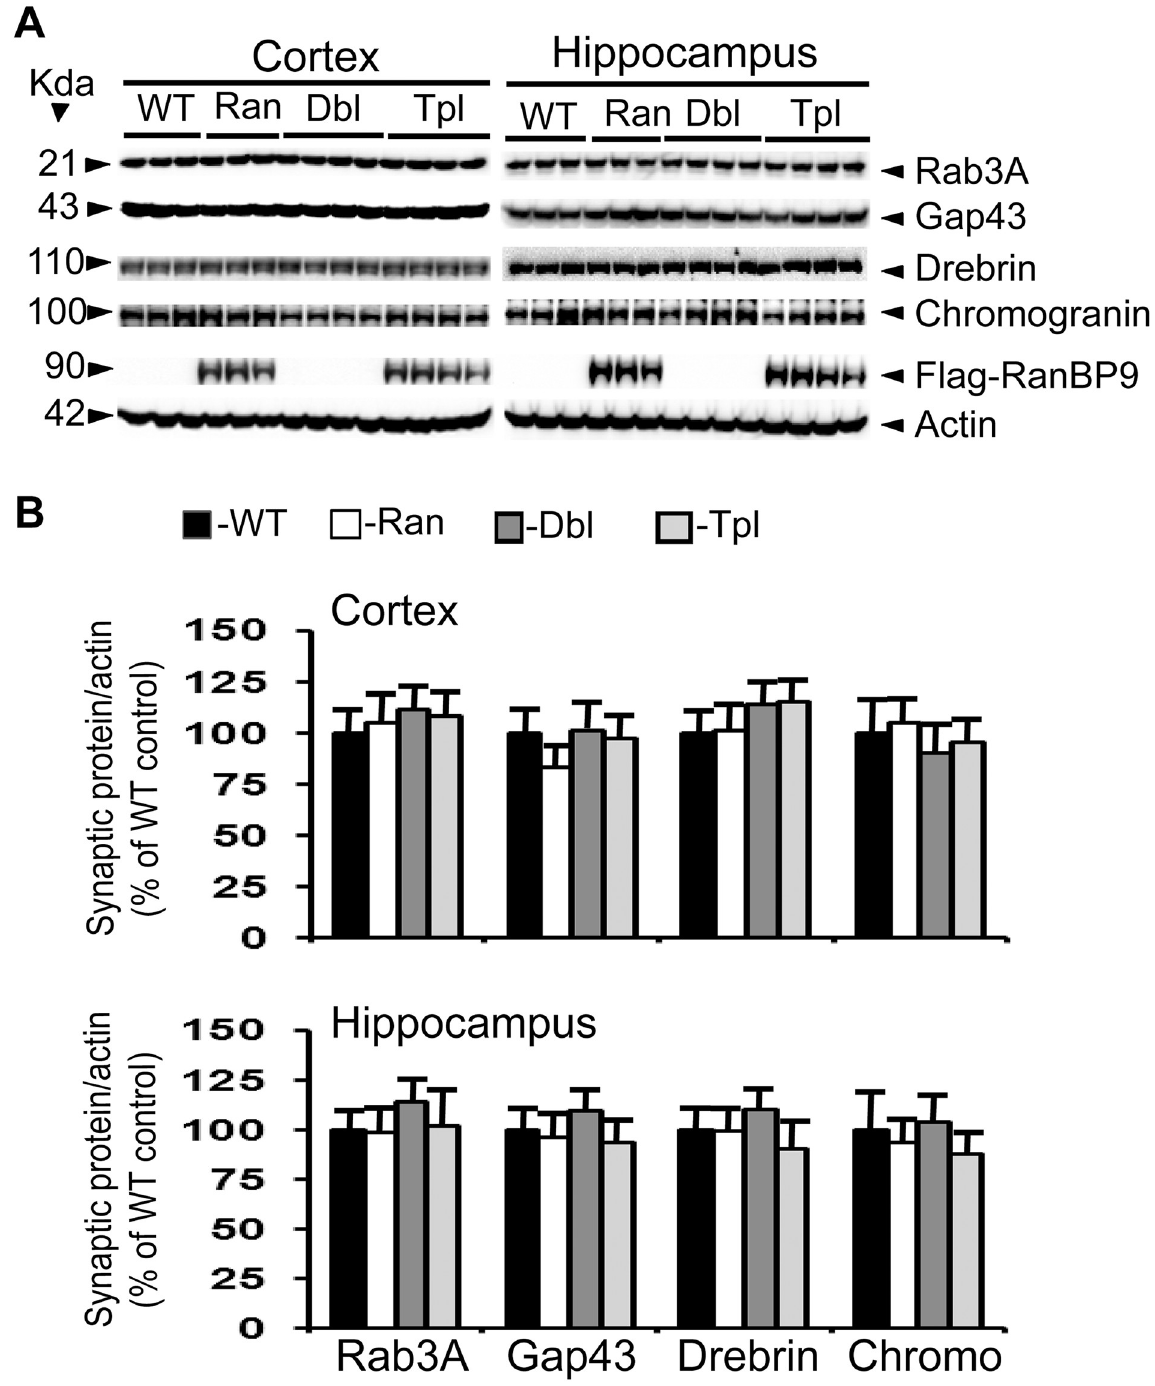
Fig 2. RanBP9 overexpression does not alter synaptic protein levels in the cortex and hippocampus at 4- months of age. A: Shows an immunoblotting analysis of rab3A, gap43, drebrin, chromogranin and the house keeping gene actin in brain samples from cortex and hippocampus. Brain homogenates from RanBP9 transgenic (Ran), AP Δ E9 double transgenic (Dbl), AP Δ E9/RanBP9 triple transgenic (Tpl) and age-matched wild-type (WT) control mice at 4-months of age were subjected to SDS-PAGE electrophoresis and probed with their respective antibodies. Flag specific monoclonal antibody detected flag-tagged exogenous RanBP9 in the RanBP9 single transgenic and AP Δ E9/RanBP99 triple transgenic mice only. Actin was used as loading control. The numbers on the left side indicate the molecular weights of each protein. B: Image J quantitation and normalization to actin levels showed no changes in the levels of any of the synaptic proteins at 4 months. The data are mean ± SEM, n = 3 for WT and RanBP9 single transgenic, and n = 4 for AP Δ E9 and AP Δ E9/RanBP9 genotypes.